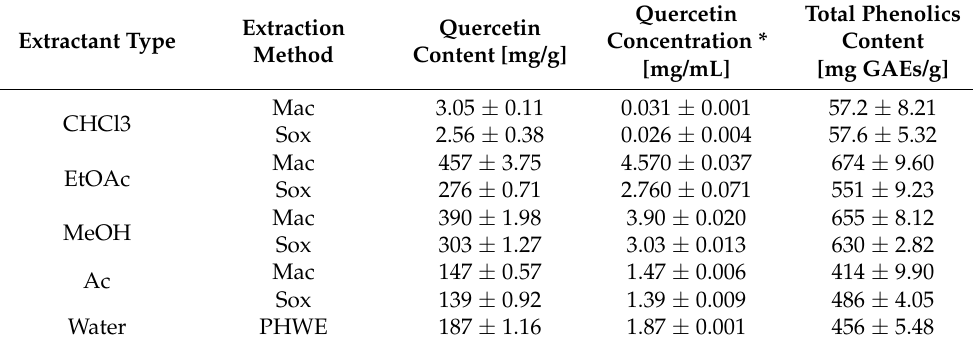
Table 1. Concentration of quercetin and the total phenolics amounts in the examined